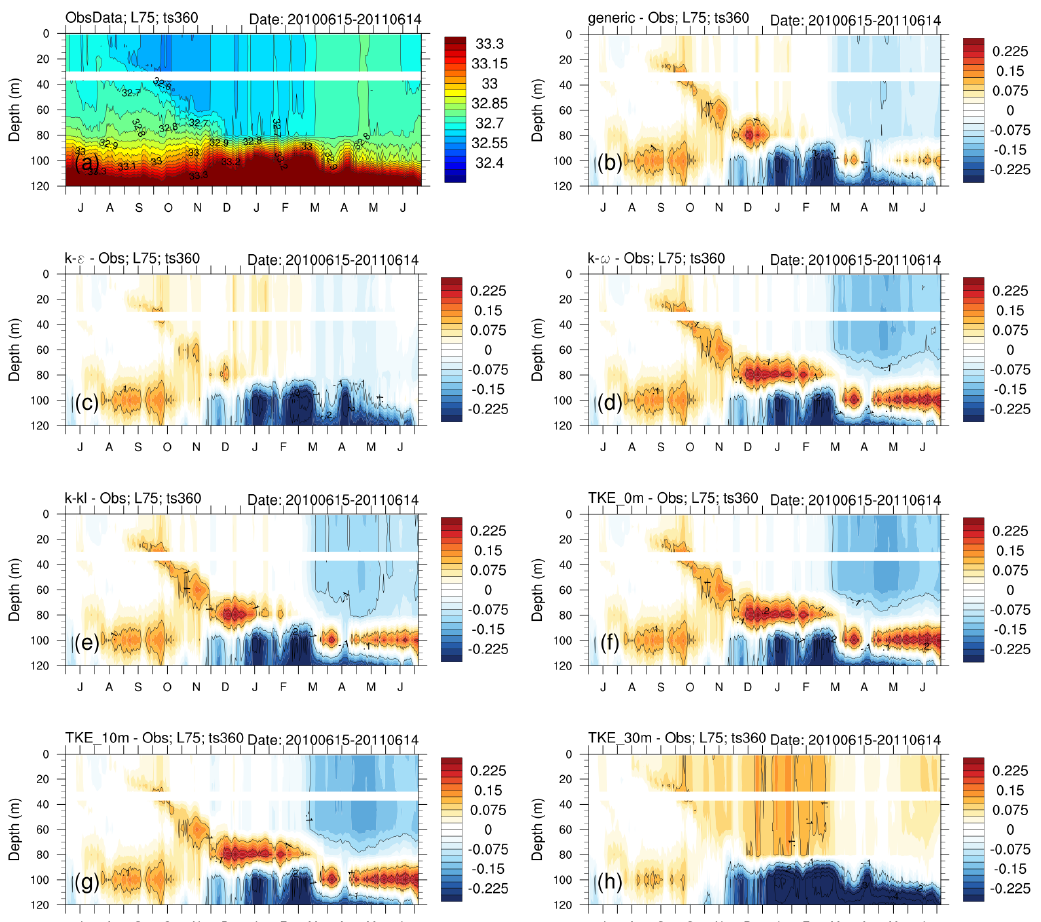
Figure 8. Observed salinity at PAPA station (a) over the study period (15 June 2010 to 14 June 2011) and the biases (model minus observed data) obtained in the simulations with all closures, with [L75; 360s]: generic (b) , k - ε (c) , k - ω (d) , k - kl (e) , TKE_0m (f) , TKE_10m (g) and TKE_30m (h) . Iso-lines are plotted every 0.1 PSU (except the iso-0, which has not been plotted).